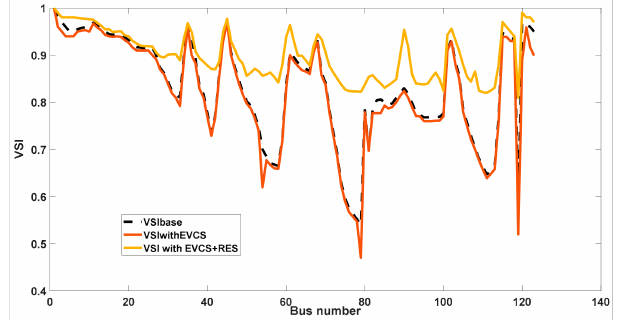
Figure 14. VSI of the IEEE 123-bus